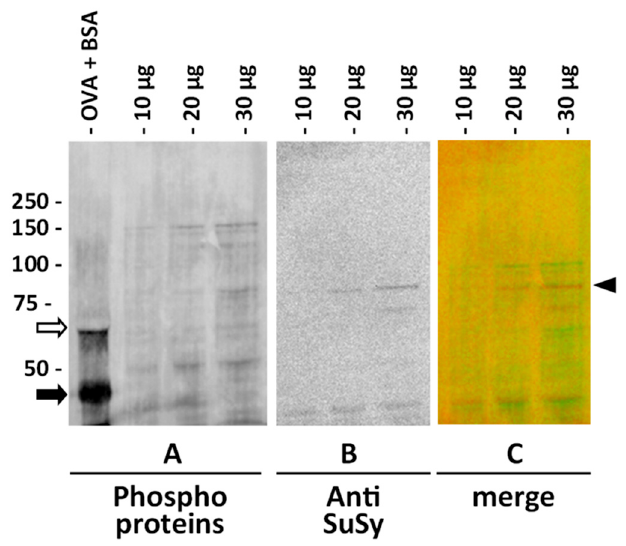
Figure 6. Test with the probe for phosphoprotein and immunoblotting with anti-sus-1 antibody on the cytosolic extract of nettle stem. ( A ) PVDF (polyvinylidene difluoride) membrane stained with phosphoprotein probe. The first lanes contained two reference proteins, BSA (white arrow, molecular weight of about 66 kD), which is not phosphorylated, and chicken ovalbumin (black arrow, molecular weight of about 45 kD), which is phosphorylated. The other lane contained increasing amounts of cytosol protein. ( B ) The same membrane in ( A ) tested with the antibody to sus-1 of Arabidopsis . SuSy is detectable as a band at about 80 kD. ( C ) Merging of the two previous images; the phosphoproteins are shown in green, while the signal of SuSy is shown in red (arrowhead).